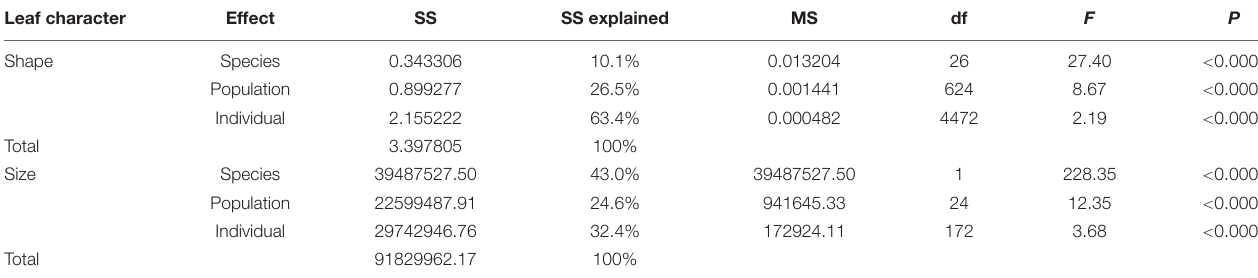
TABLE 2 | The results of multivariate analysis of variance (MANOVA) test on Procrustes distance and univariate analysis of variance (ANOVA) test on centroid size. Leaf character